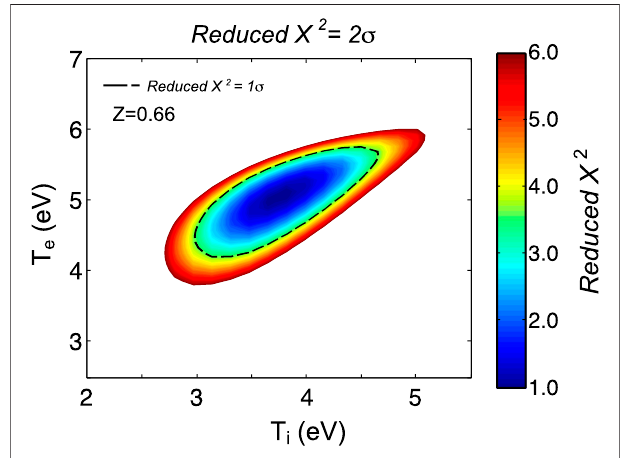
FIGURE 5 | Reduced chi squared contour plot showing the deviations between theoretical fi ts to the measured XRTS signal strength (excluding the inelasticandthermaldiffusescatter)forvariouselectronandiontemperatures, attimet=2.5 ps?TheplotshowsaglobalminimumatT e =5 eVandT i = 3.8 eV. All possible T e and T i conditions within a 2 σ deviation are plotted. The black dashed line indicates a measured 1 σ deviation.